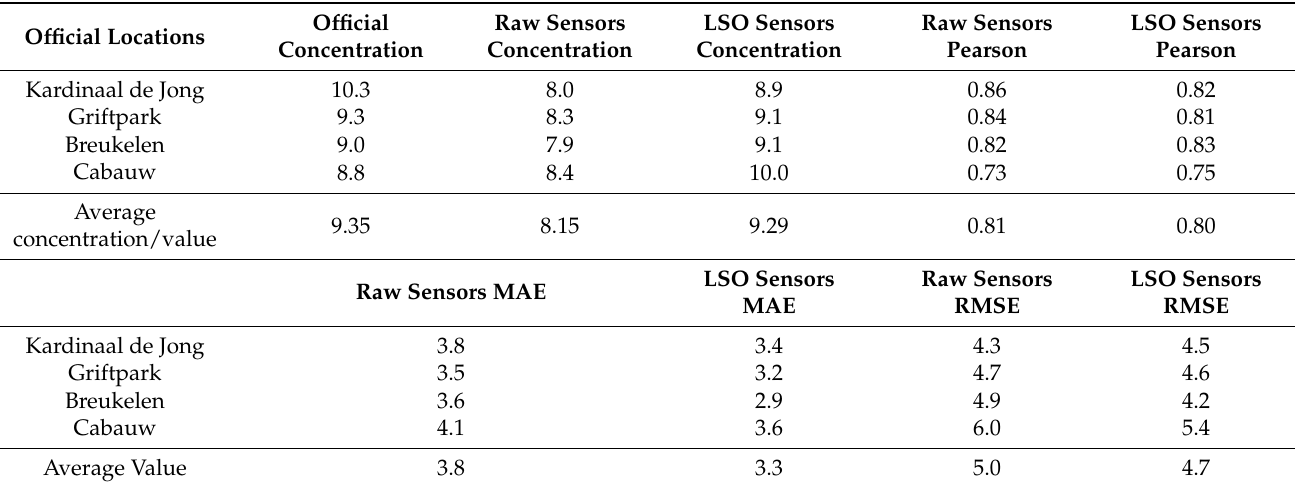
Table 1. Average sensor values, official measurements, Mean Average Error, Pearson correlation, and Root Mean Square Error for several calibration options. All concentrations are in microgram per cubic